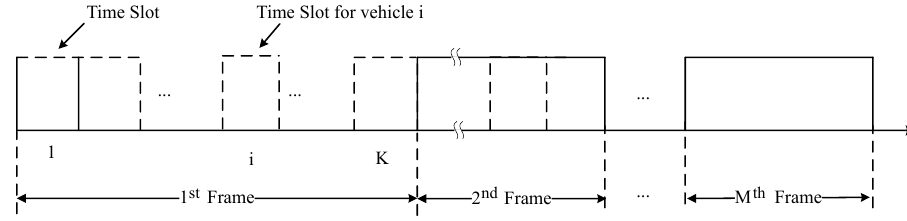
Figure 1. Contents of Scheduling Time.